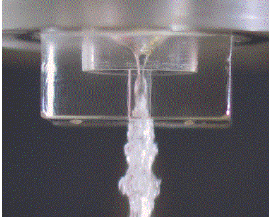
Fig. 4 Detail of jet inside